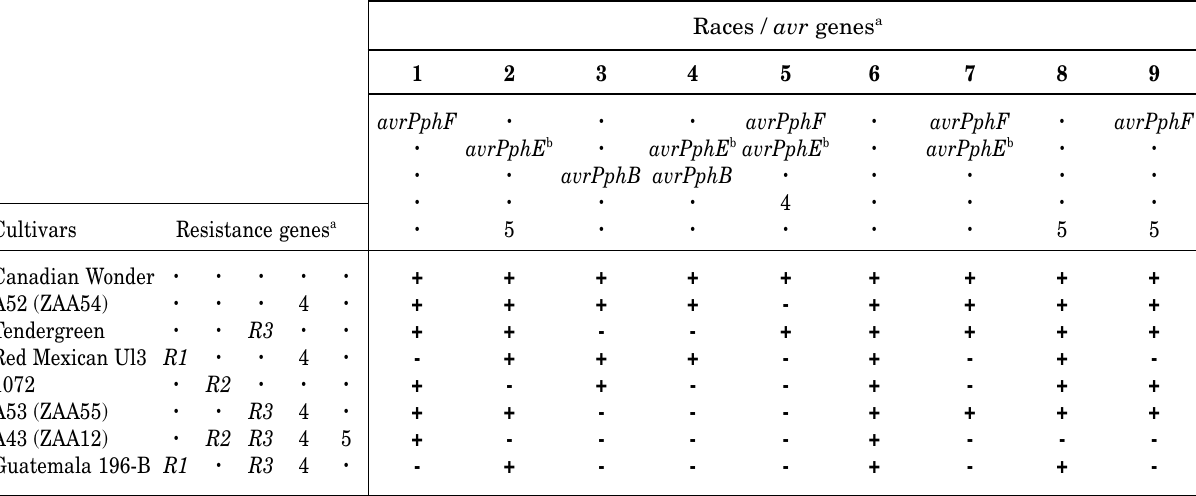
Table 5. Partly validated model to explain observed interactions between races of Pseudomonas syringae pv. pha- seolicola and cultivars of the host, bean.